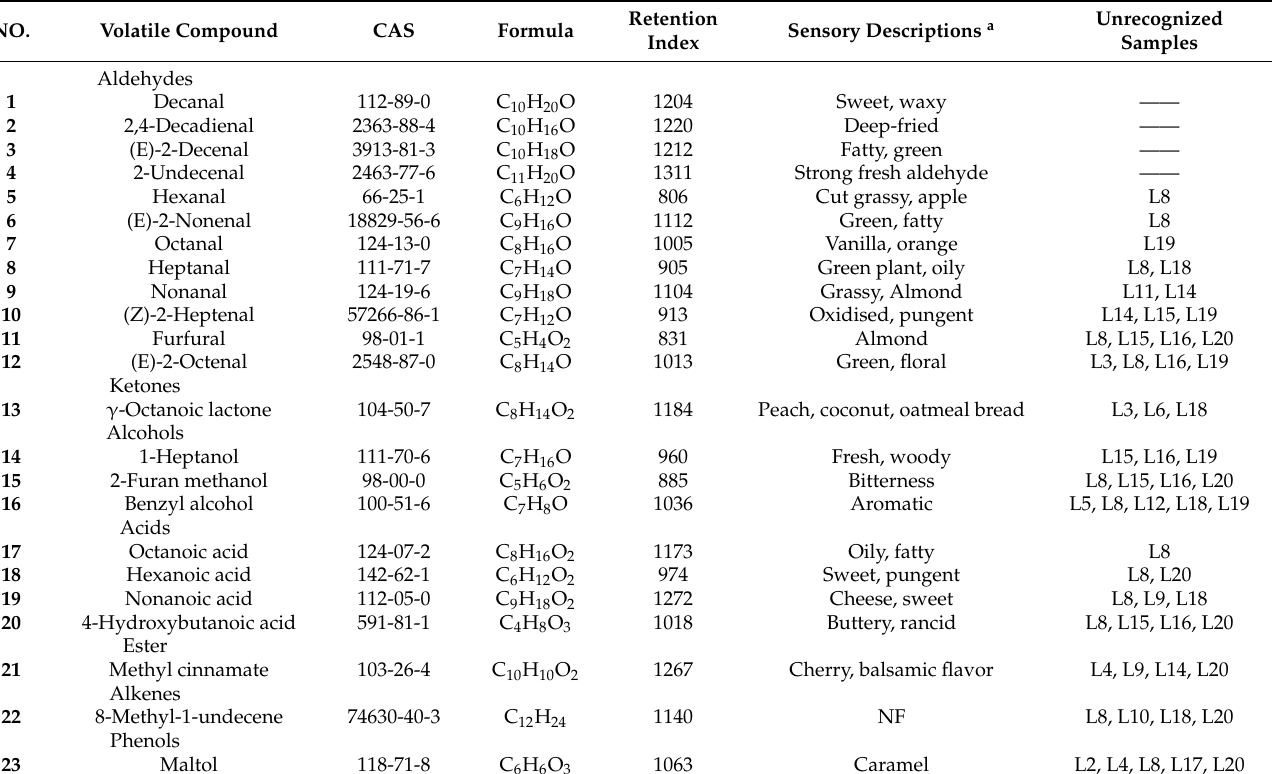
Table 1. Information of common volatile compounds of VCO from 20 geographic